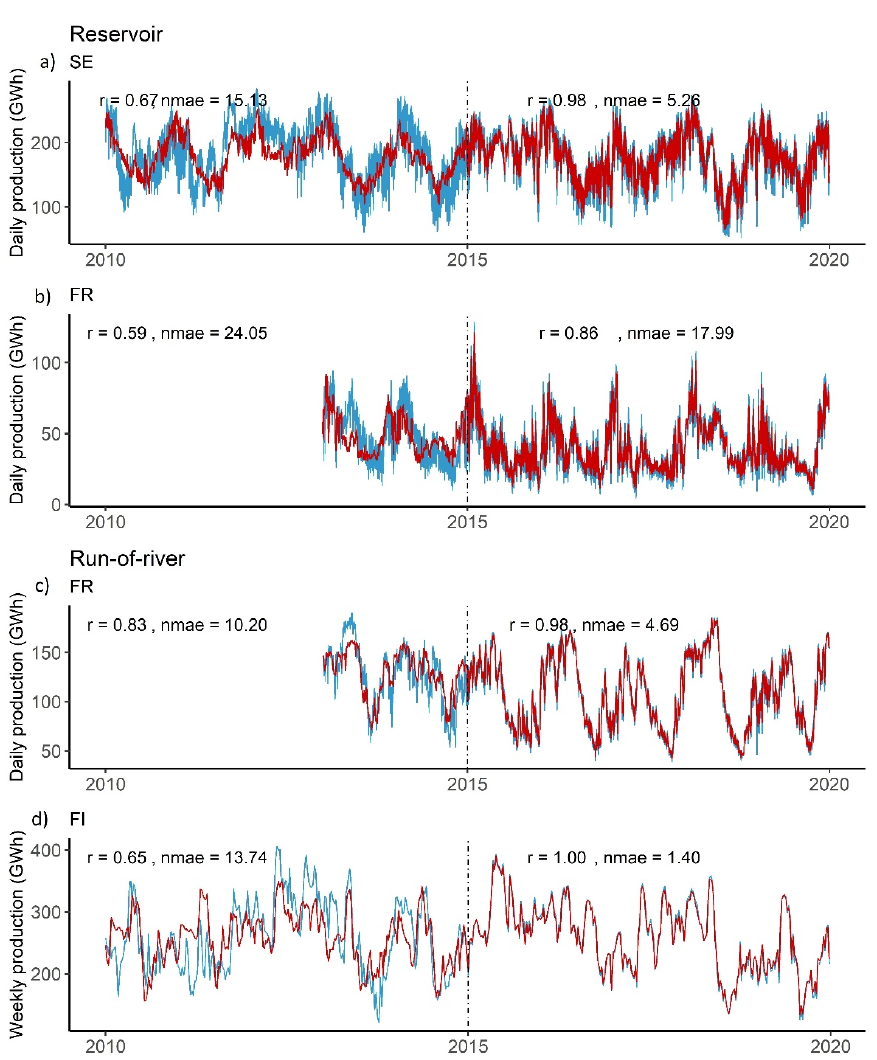
Figure 5. Time series of observed (blue) and reconstructed (red) hydro power production of Swedish reservoir-based ( a ) in 2010–2014, French reservoir-based ( b ) and run-of-river ( c ) in 2013–2014 and Finnish run-of-river ( d ) in 2010–2014) generation. The dash-dotted vertical lines indicate 1 January 2015, marking the separation between the historical reconstruction (red curve left of the line) and the simulated data over the training period 2015–2019 (red curve right of the line). Note that observed data come from different sources: in the period 2010–2015, data are from non-ENTSO-E sources, e.g. Réseau de Transport d’Électricité (RTE) for France, and Open Power System Data (OPSD) for Finland and Sweden; while in the period 2015–2019, data are from ENTSO-E—the same source as the training period for the model, and hence the good agreement between red and blue curves over this period. Considering that the model only uses climate data and does not include any power plant information, these reconstructed time series show very encouraging results (see correlation